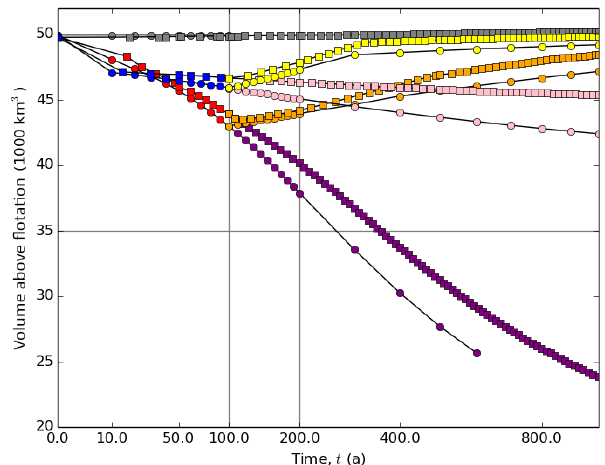
Figure 8. As for Fig. 7 but for volume above flotation (VAF). VAF follows a similar trend as the grounded area (Fig. 7): it decreases rapidly when forced by melt rates and increases more slowly to nearly the initial state when ocean forcing disappears. In both mod- els, the ice sheet is more sensitive to basal melt near the ground- ing line than to extreme high basal melt representing calving at the front. However, BISICLES_D produces slightly less retreat under both ocean forcing scenarios than BISICLES.